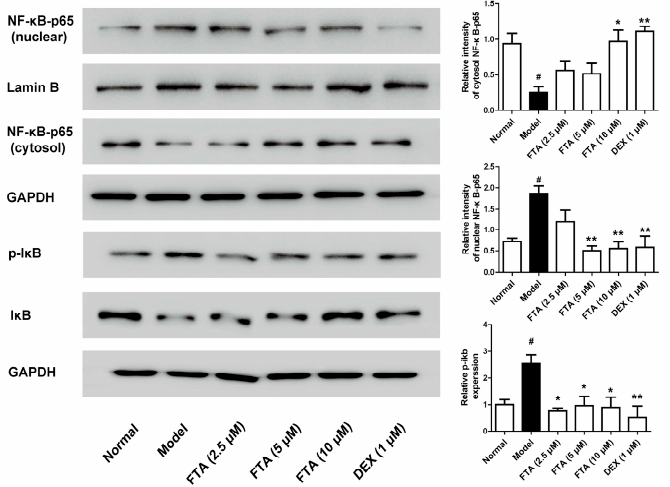
Figure 4. FTA reduces the expressions of cytokines in zymosan-stimulated RAW 264.7 cells. Cells were pretreated with zymosan (10 μ g/mL) for 30 min, then treated with FTA (2.5, 5, 10 μ M) and DEX (1 μ M) for 4 h, and supernatants and total cells were collected. ( A ) Effect of FTA on the cell viability of macrophage RAW 264.7 cells. Cells were incubated with or without FTA (1.25–80 μ M) and DEX (1 μ M) for 24 h. Cell viability was determined by MTS; ( B ) The protein of cytokines were determined by ELISA; ( C ) Cytokine mRNA levels were quantified by QRT-PCR. Data were expressed as means ±